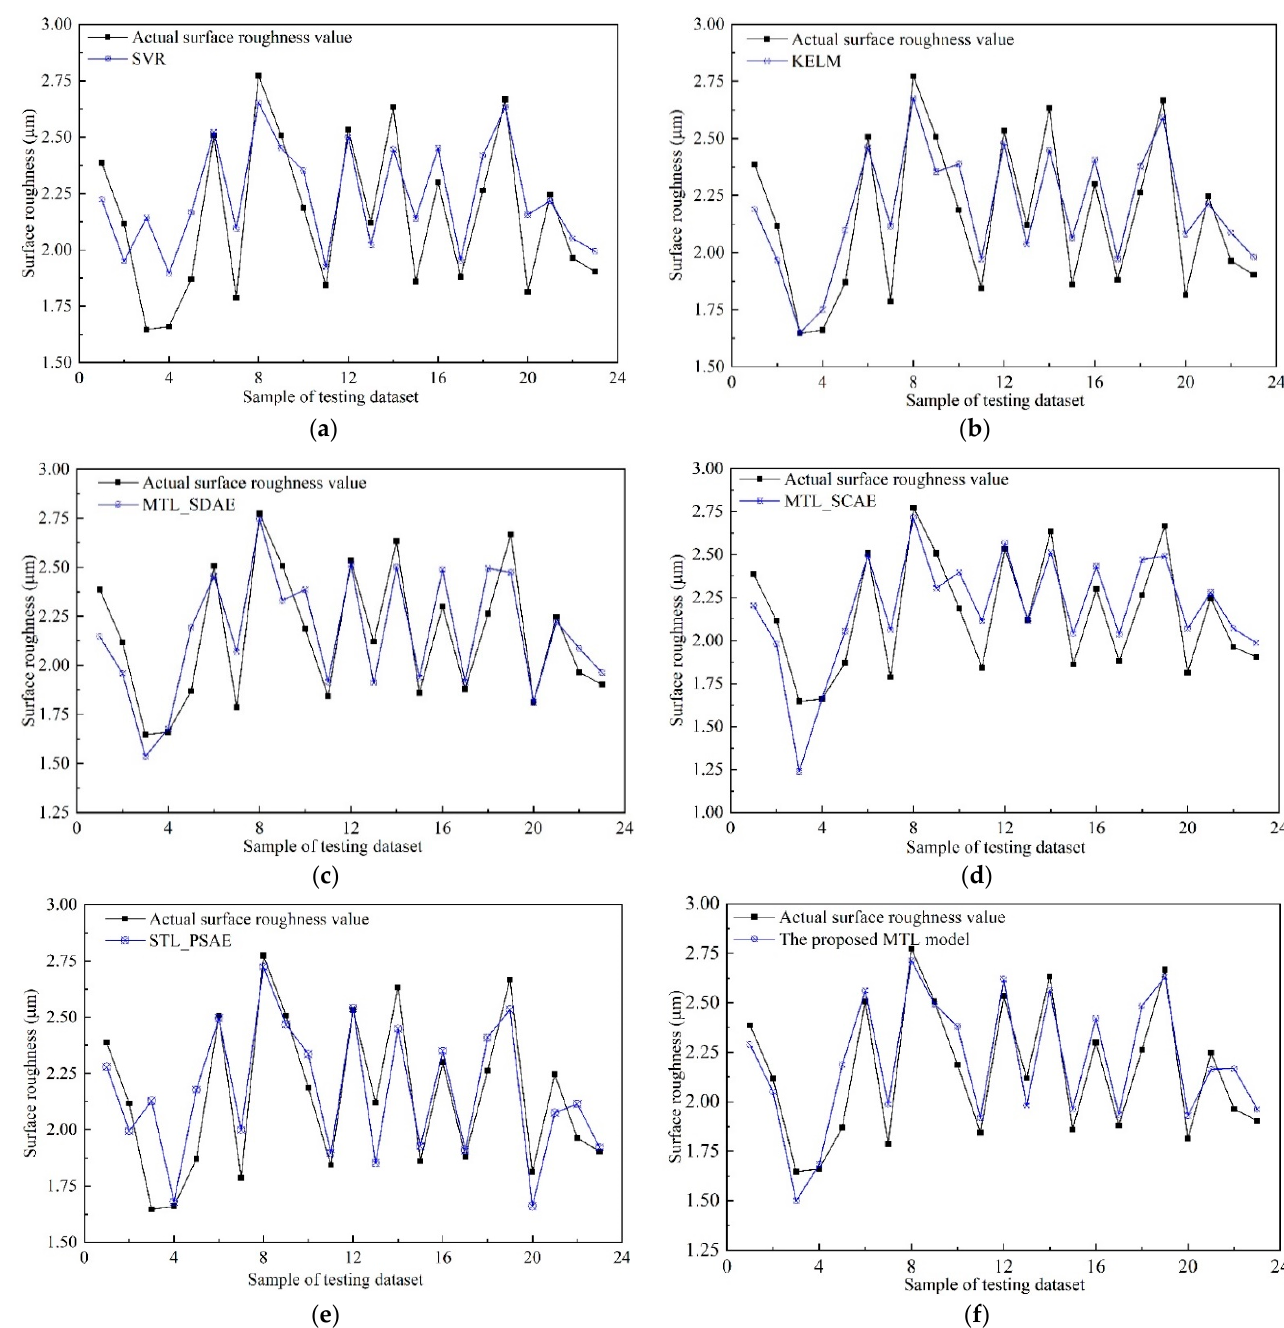
Figure 15. Surface roughness prediction results of different models. ( a ) SVR; ( b ) KELM; ( c )